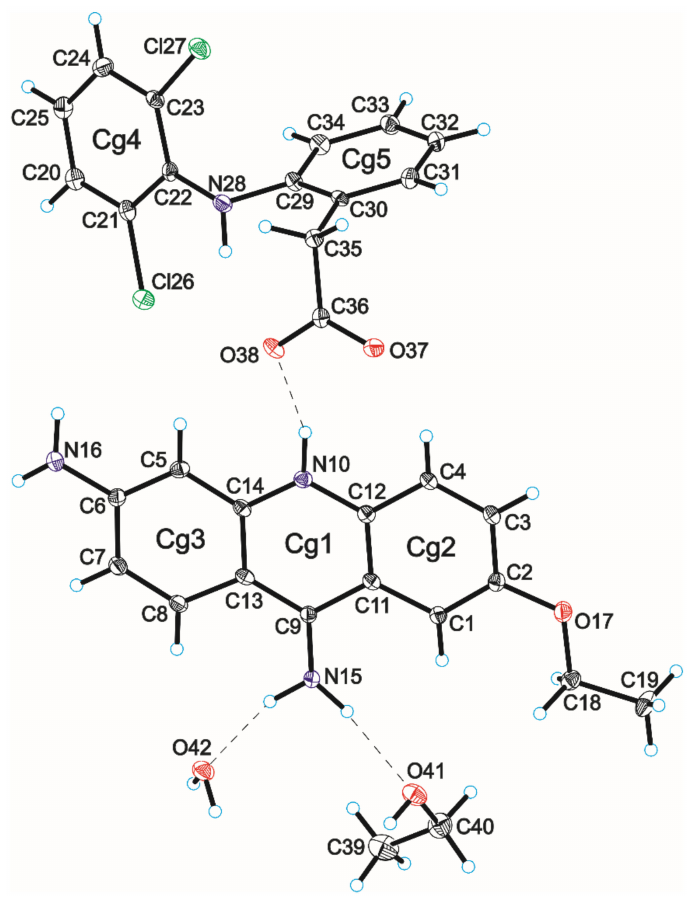
Figure 4. Molecular structure of compound 2 showing the atom-labelling scheme (Cg1, Cg2, Cg3, Cg4, and Cg5 denote the ring centroids; hydrogen bonds are represented by dashed